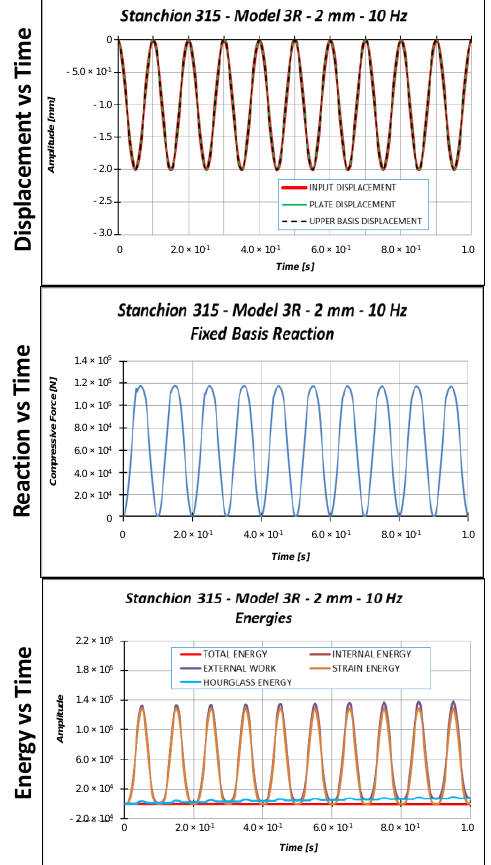
Figure 16. Displacement, reaction, and energies as a function of time: 2.0 mm applied displacement. Materials 2020 , 13 , x FOR PEER REVIEW